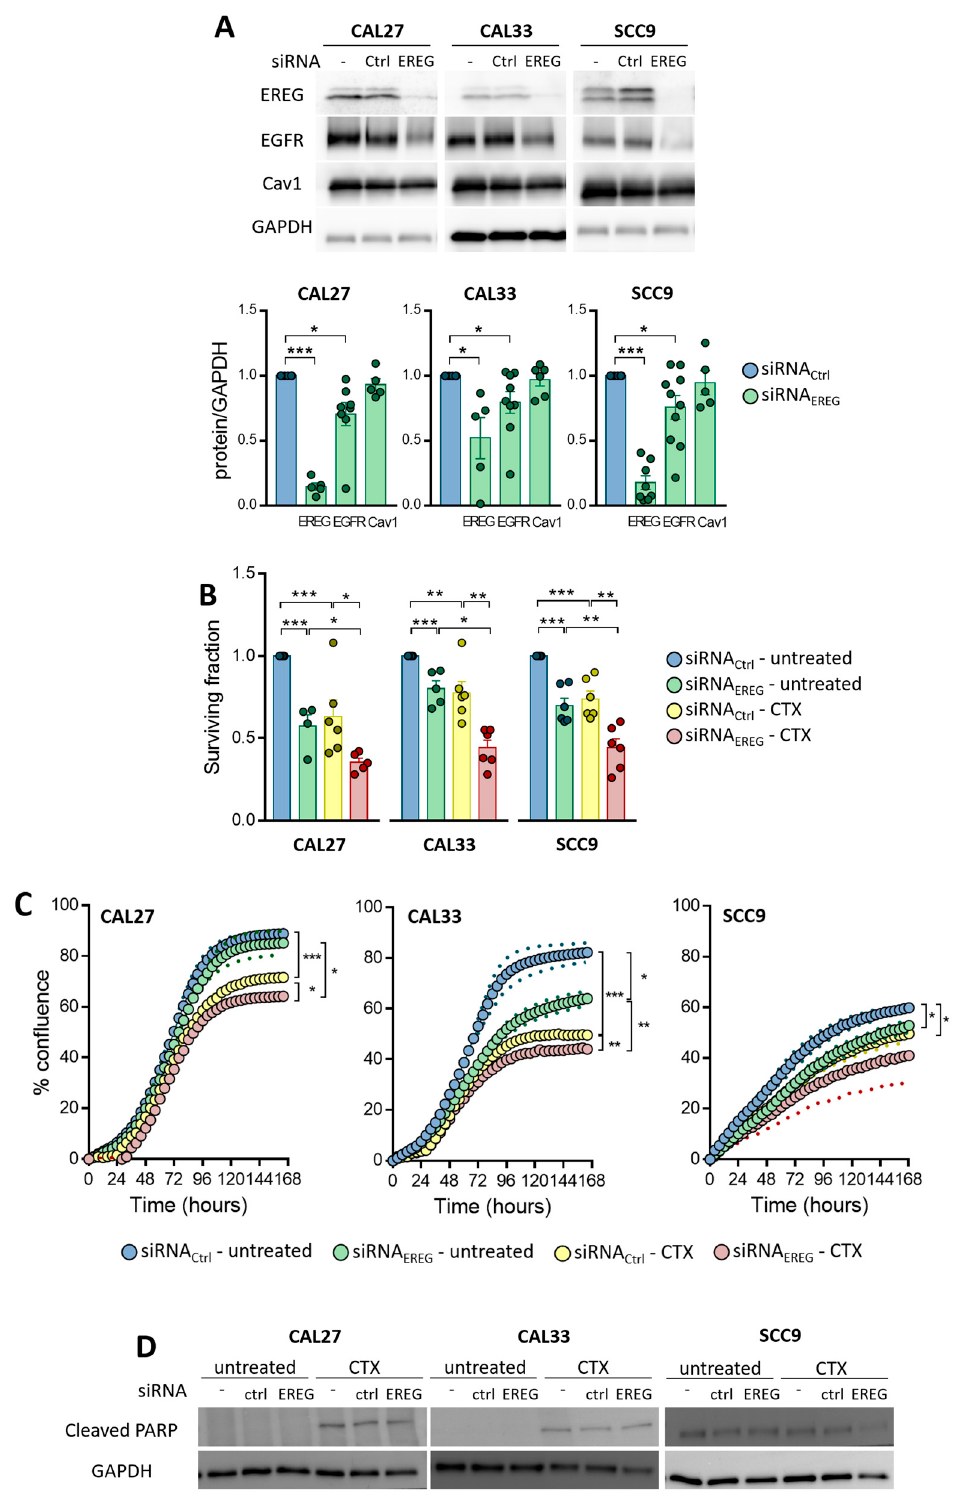
Figure 1. ( A ) Expression of EREG, EGFR, CAV1 and GAPDH was determined by Western blot in CAL27, CAL33 and SCC9 cells untransfected and transfected with siRNA Ctrl or siRNA EREG . Histograms represent the mean ± SEM (CAL27 and CAL33 n = 6–11 and SCC9 n = 6–13, with * p < 0.05 and *** p < 0.001) of the protein expression in siRNA Ctrl - or siRNA EREG- transfected cells normalized with GAPDH. ( B ) Histograms show the surviving fraction of CAL27, CAL33 and SCC9 cells transfected with siRNA Ctrl or siRNA EREG and treated with solvent or 30 nM CTX. Data